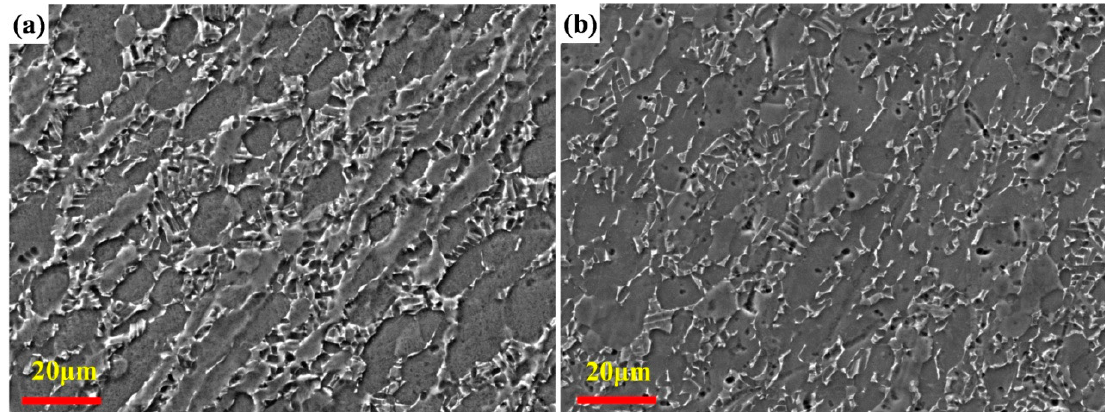
Figure 1. The microstructure of Ti-6Al-4V alloy: ( a ) as-received alloy (NT Ti alloy) and ( b ) after cryogenic treatment for 24 h (CT Ti alloy).